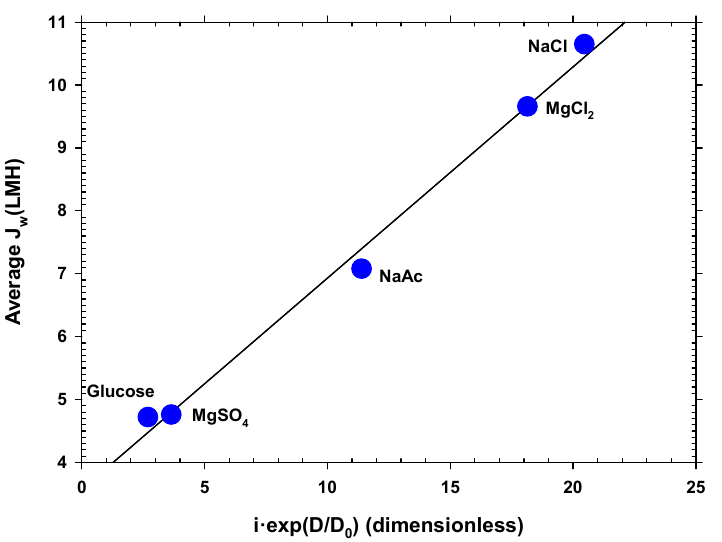
Figure 5. Average water flux versus a correlation between the Van’t Hoff factor and the diffusion coefficient of the different solutes. Here, NaAc stands for sodium acetate (CH 3 COONa). It seems clear that sodium chloride is and was expected to be one of the draw solu- tions with the highest water flow, as has been pointed out in the literature [22,28]. (cid:1836) (cid:3046) should increase with the saline permeability of the membrane and with the con- centration gradient between the two faces of the active surface. At first, an increase in (cid:1836) (cid:3050) should decrease the concentration on the side of the active layer in contact with the DS (and therefore (cid:1836) (cid:3046) ), as observed in Figure 6 for all the studied salts except MgCl 2 . In this case, the concentration of Cl - anions is twice that of the other salts, increasing the concen- tration gradient. Given that the membrane is negatively charged, it means that Mg 2+ , with two positive charges, could pass through the pores easier than Na + [52]. Furthermore, Mg 2+ is smaller than Na + , as shown in Table S5 in the Supplementary Materials [53]. All of these factors can explain the anomalous behavior of MgCl 2 with quite high average reverse flux.